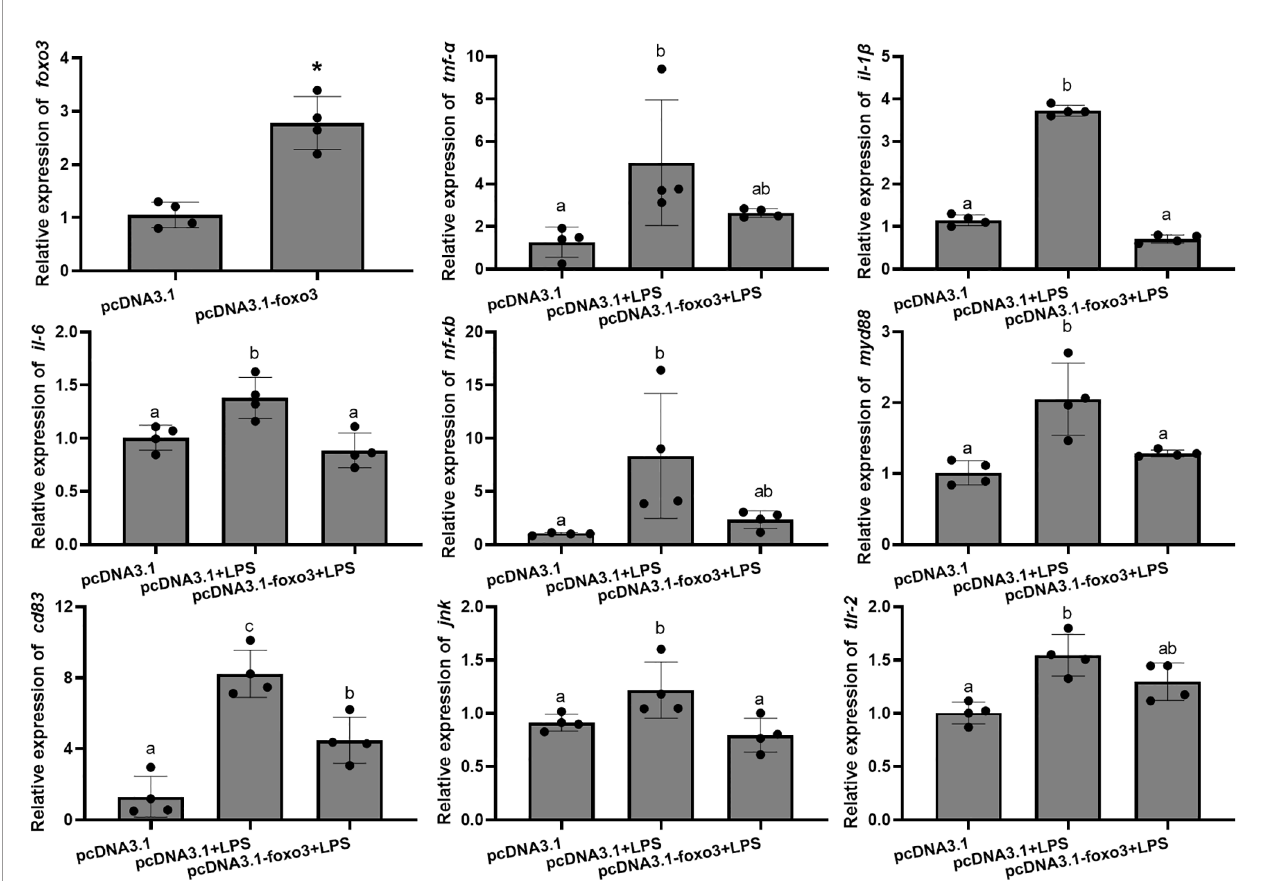
FIGURE 11 | Relative mRNA levels of foxo3 , tnf- a , il-1 b , il-6 , nf- k b , myd88 , cd83 , jnk , tlr-2 in turbot liver. The results are expressed as the mean ± standard deviation (n = 4). ‘ * ’ means signi fi cantly different between two group ( P < 0.05). The different letters are signi fi cantly different ( P <